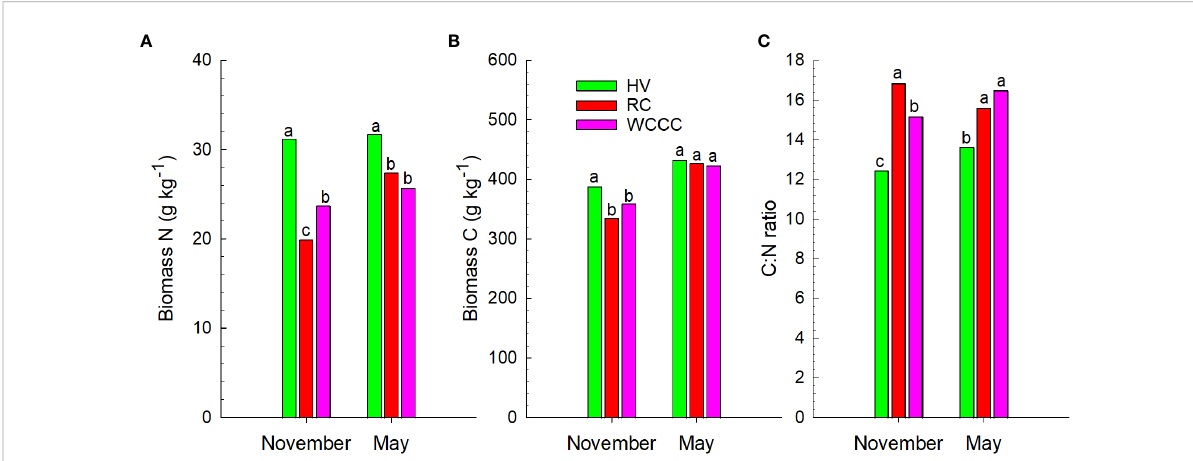
FIGURE 1 Three-year average (A) N content in biomass, (B) C content in biomass, and (C) C:N ratio for cover crop above-ground biomass at fall freeze-up (November) and late spring (May). HV, hairy vetch; RC, red clover; WCCC, white-crimson clover mix. Bars for the same parameter and sampling time are not signi fi cantly different ( P = 0.05) if labelled with the same